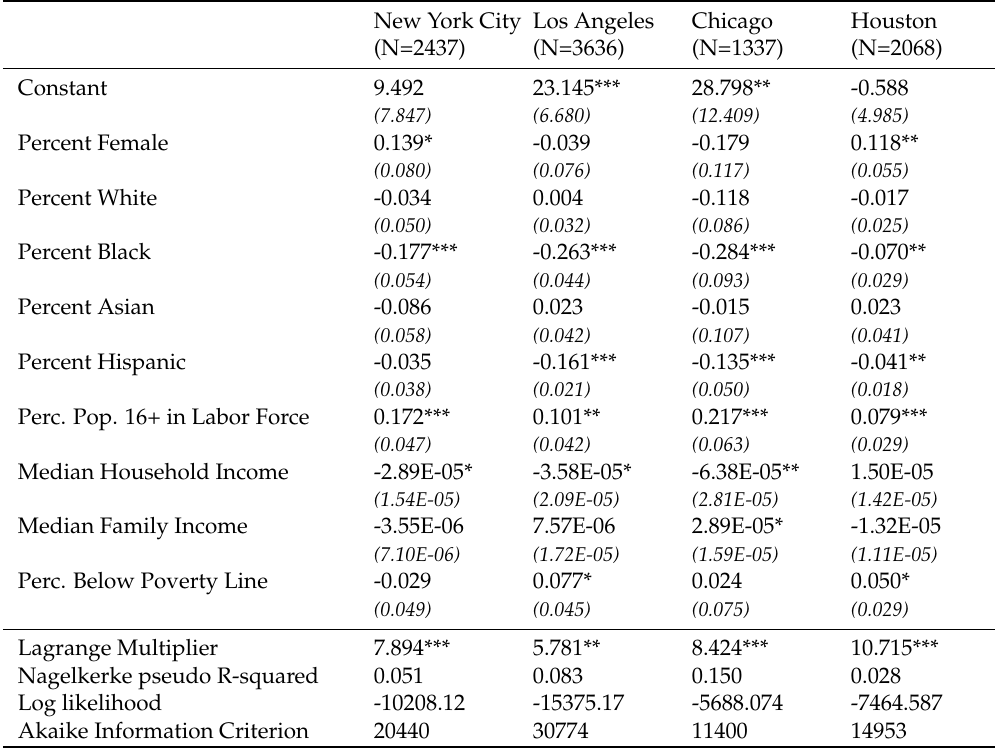
Table 8: Spatial error regression model results for change in visit duration to the Restaurant place type, split by